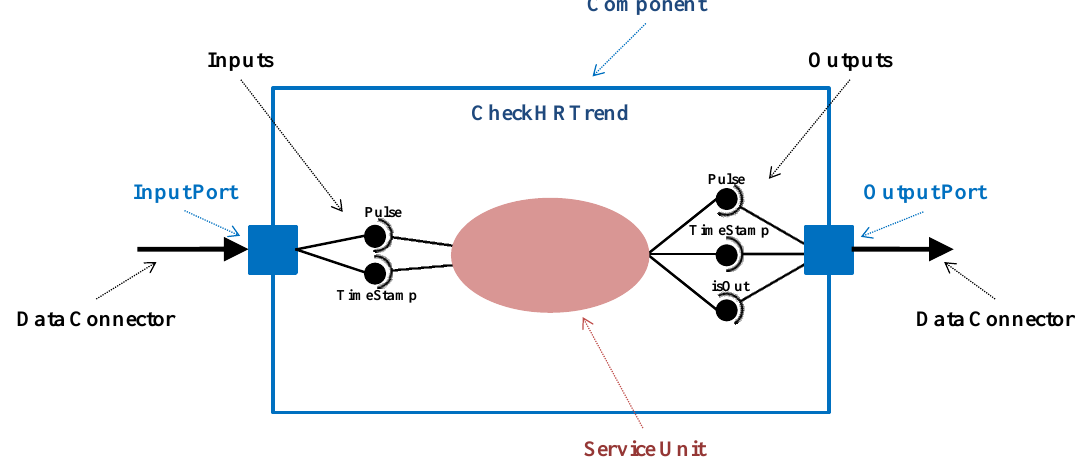
Figure 2. Detailed representation of the CheckHRTrend component.